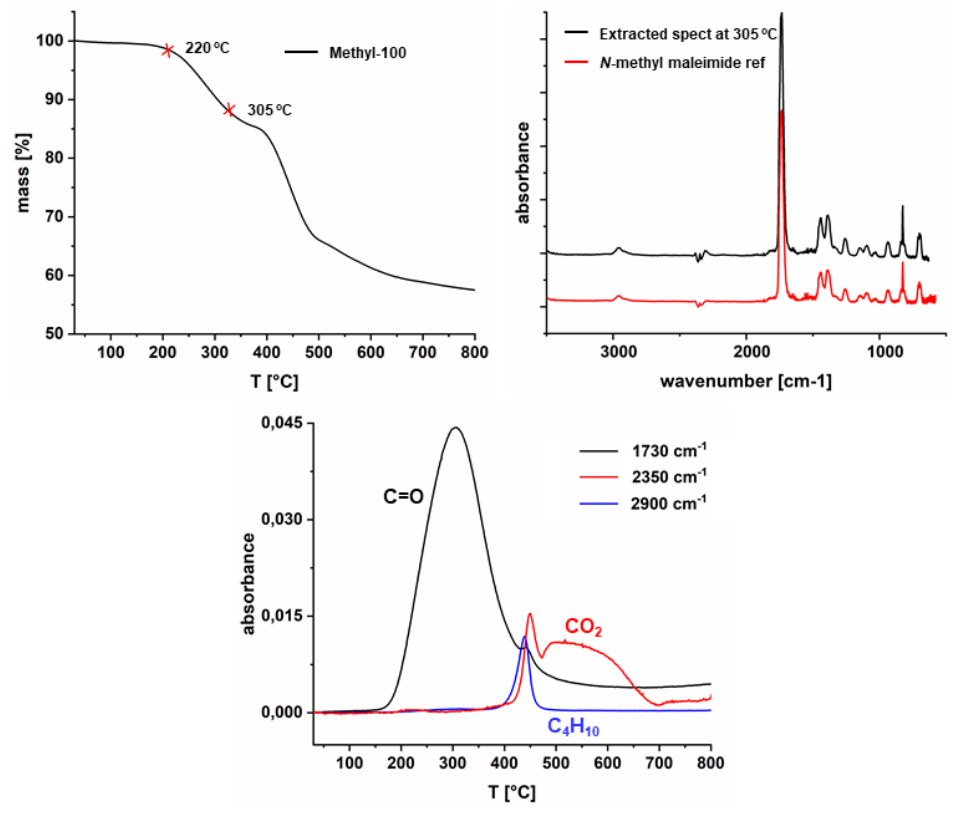
Figure 6. TG-FTIR spectrum of methyl-100.